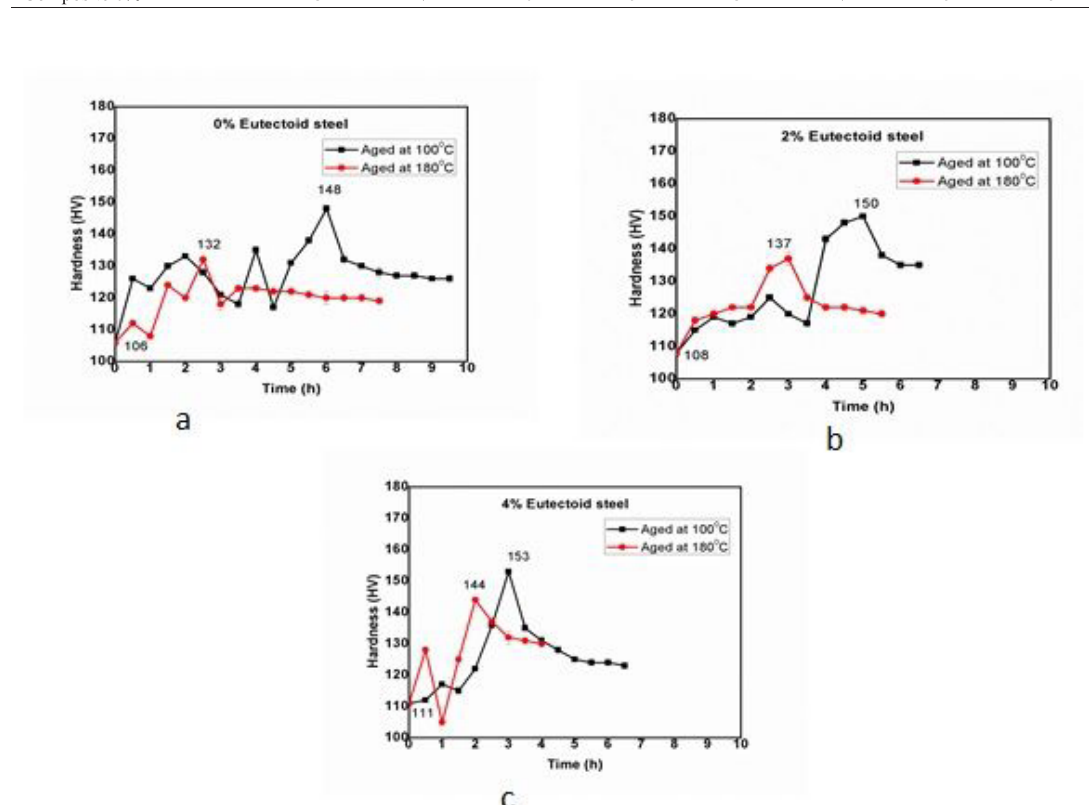
Figure 5. Hardness distribution during conventional aging (a) 0 wt% steel powder (b) 2 wt% steel powder (c) 4 wt% steel powder (d) 6 wt% steel powder